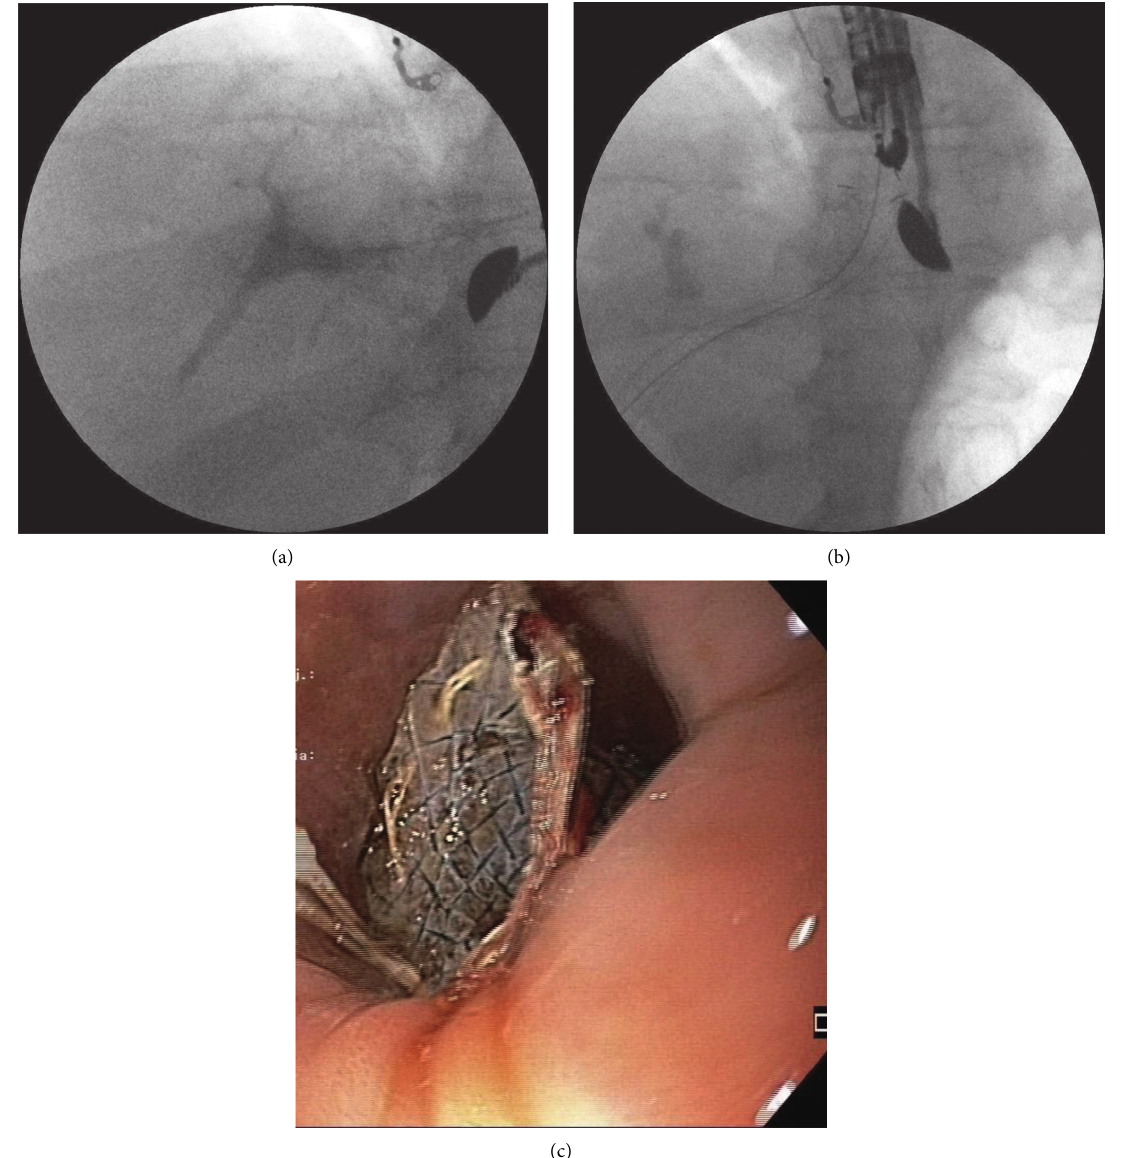
Figure 1: (a–c) EUS-guided hepaticoesophagostomy in a 57-year-old patient with an irresectable tumor of the pancreatic head and left hepatic lobe